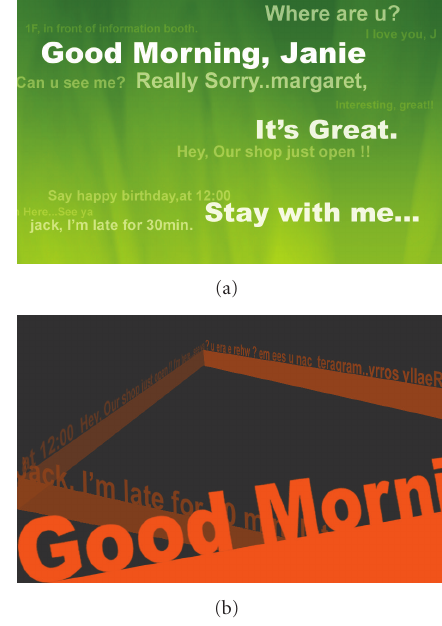
Figure 2: System overview.